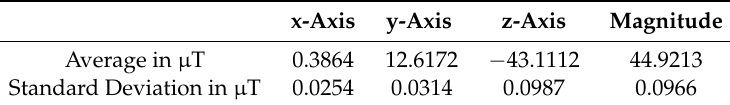
Table 10. Magnetometer measurements.